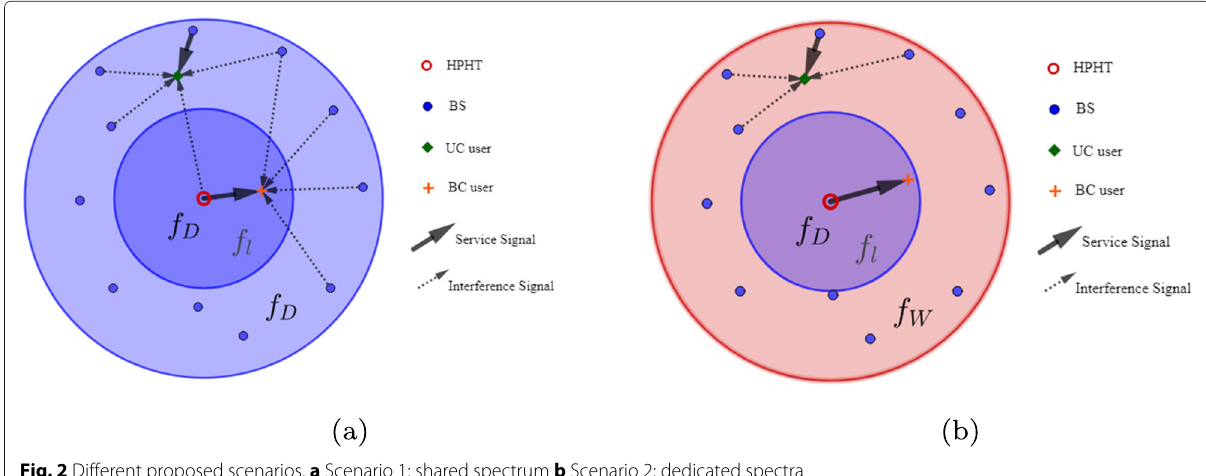
Fig. 2 Different proposed scenarios. a Scenario 1: shared spectrum b Scenario 2: dedicated